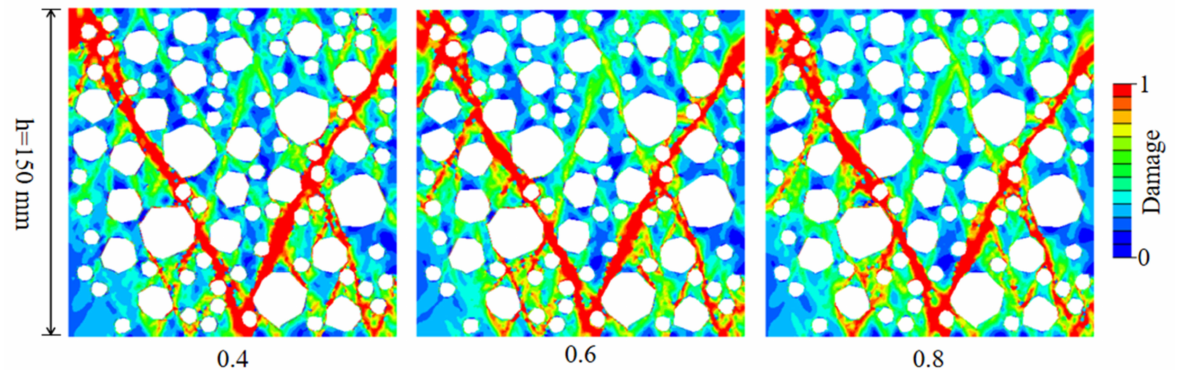
Figure 15. The effect of the strength of ITZ on failure mode of RAC under uniaxial